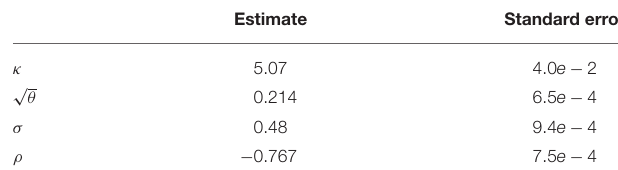
TABLE 1 | The parameters of Heston’s model along with their standard errors obtained from the Fisher information matrix if we assume they were estimated from the components of the VIX between October 16th 2003 until August 31st 2015.